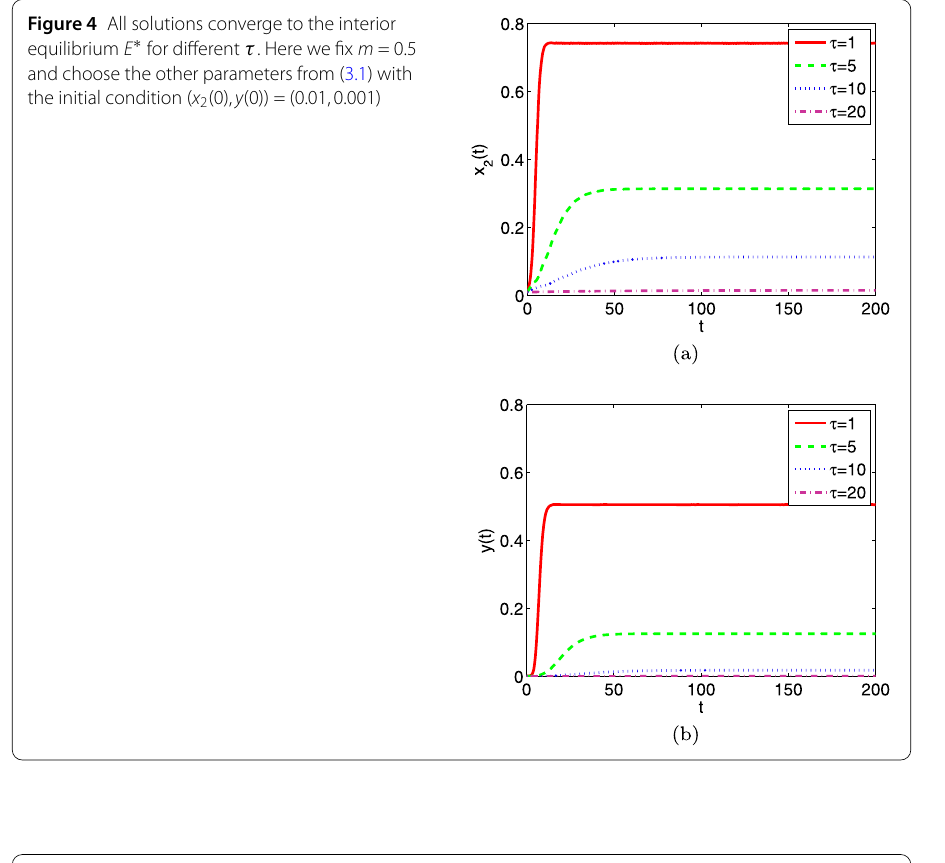
Figure 5 The relation curves of x ∗ 2 and y ∗ versus τ . Here we fix m = 0.5 and choose the other parameters from